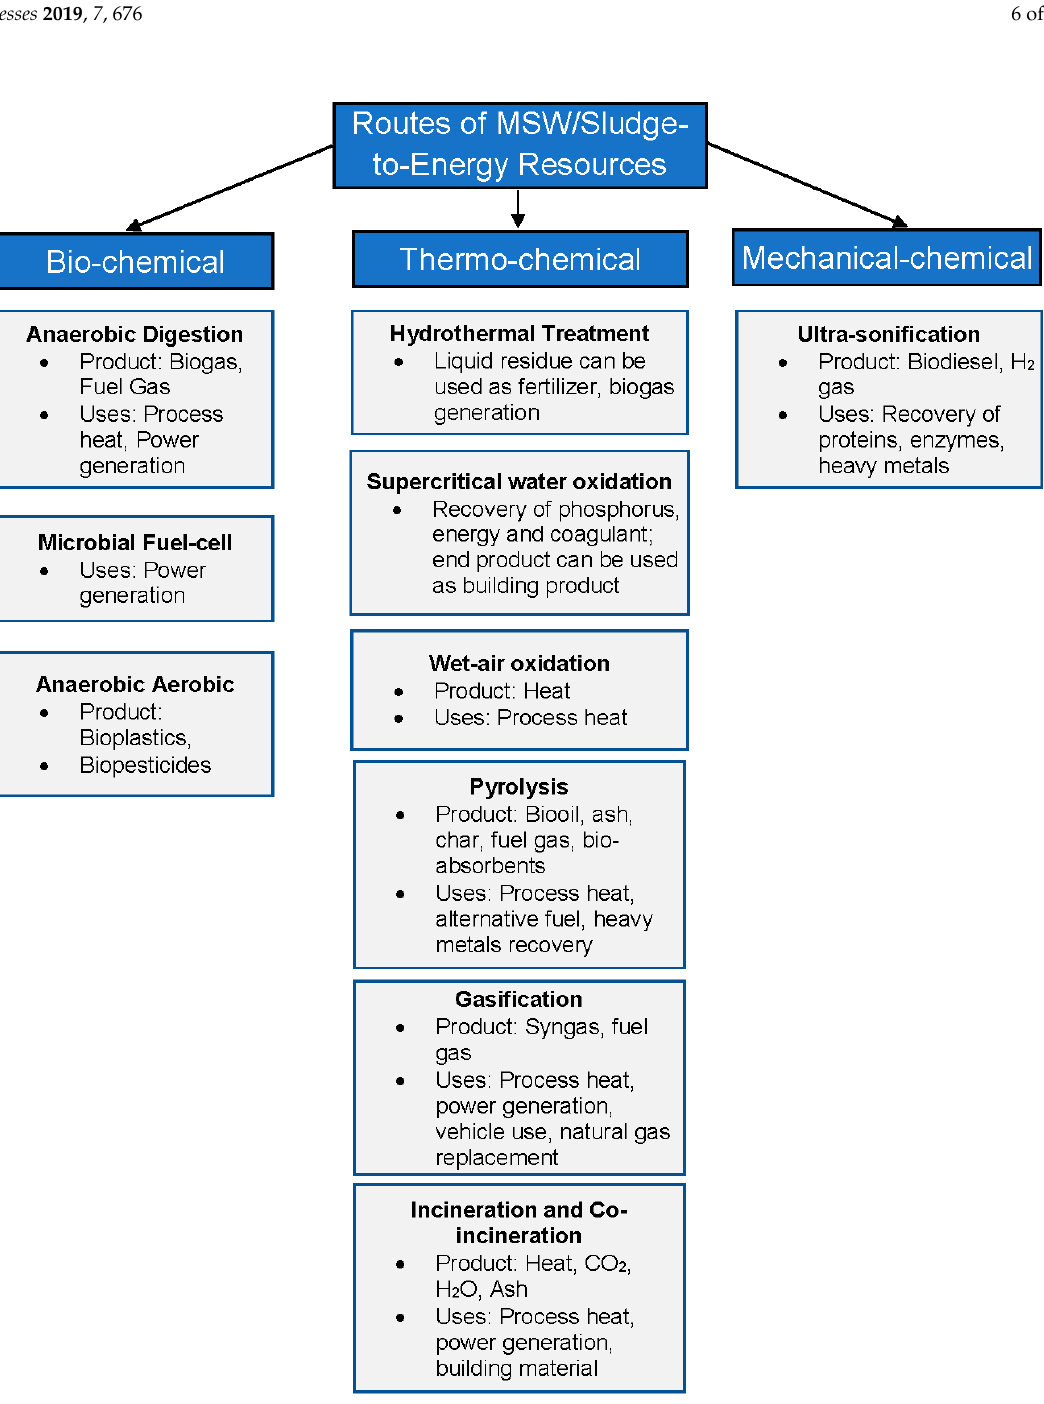
Figure 6. The various routes of waste-to-energy (WTE) treatment available [17].